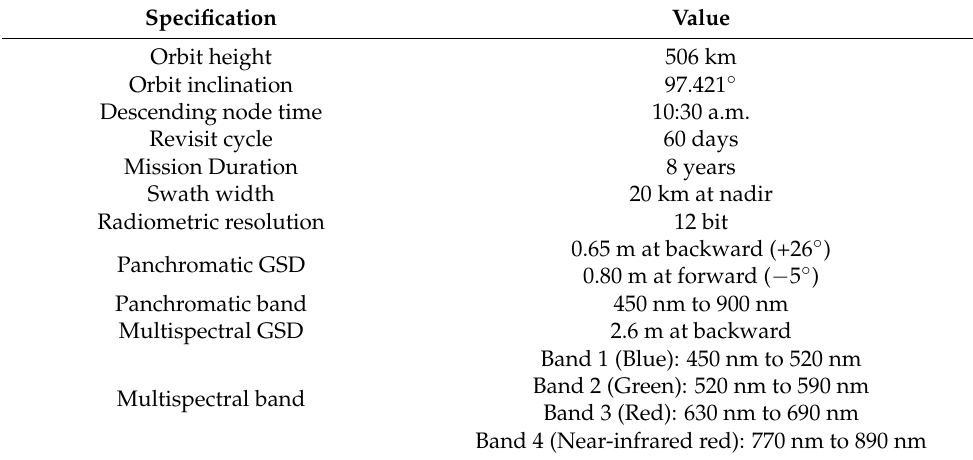
Table 1. Specifications of the GF-7